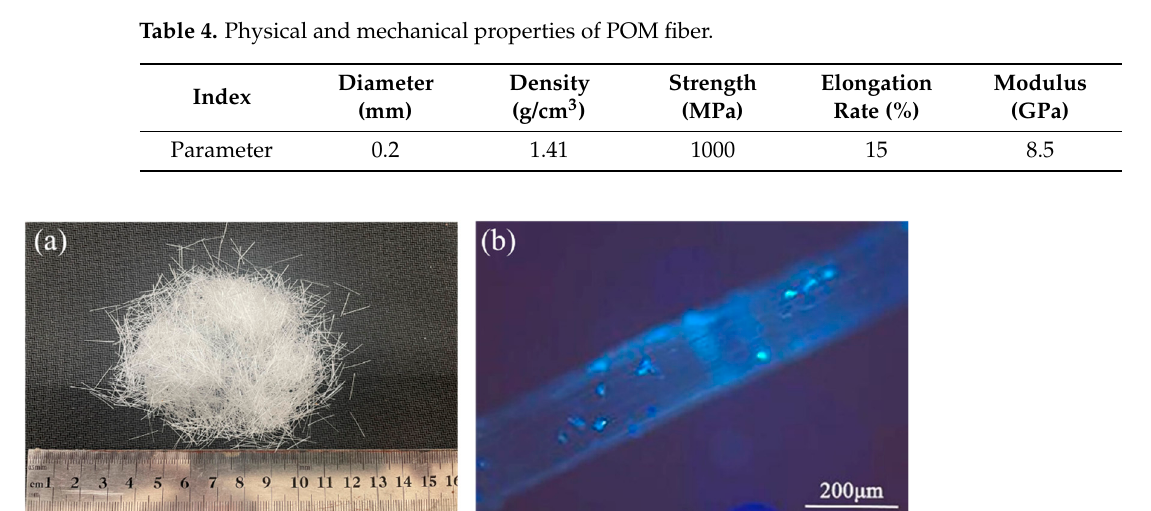
Figure 3. ( a ) Macro and ( b ) micro morphologies of POM fibers. Table 1. Material properties of cement. Table 5. Mix proportions of OPC and